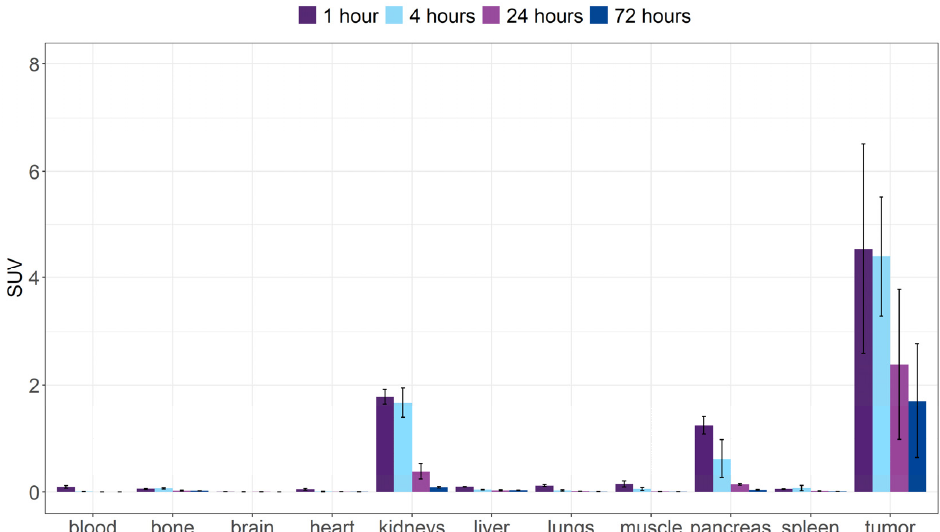
Figure 6. Ex vivo biodistribution over time expressed as standard uptake value of [ 153 Sm]Sm-DOTA-TATE in CA20948 xenografted mice. Values represent mean ± standard deviation ( n = 3–4). Table 2. Tumor-to-kidney SUV ratios at different time points post-injection (p.i.) of [ 153 Sm]Sm-DOTA-TATE in CA20948 xenografted mice. Time